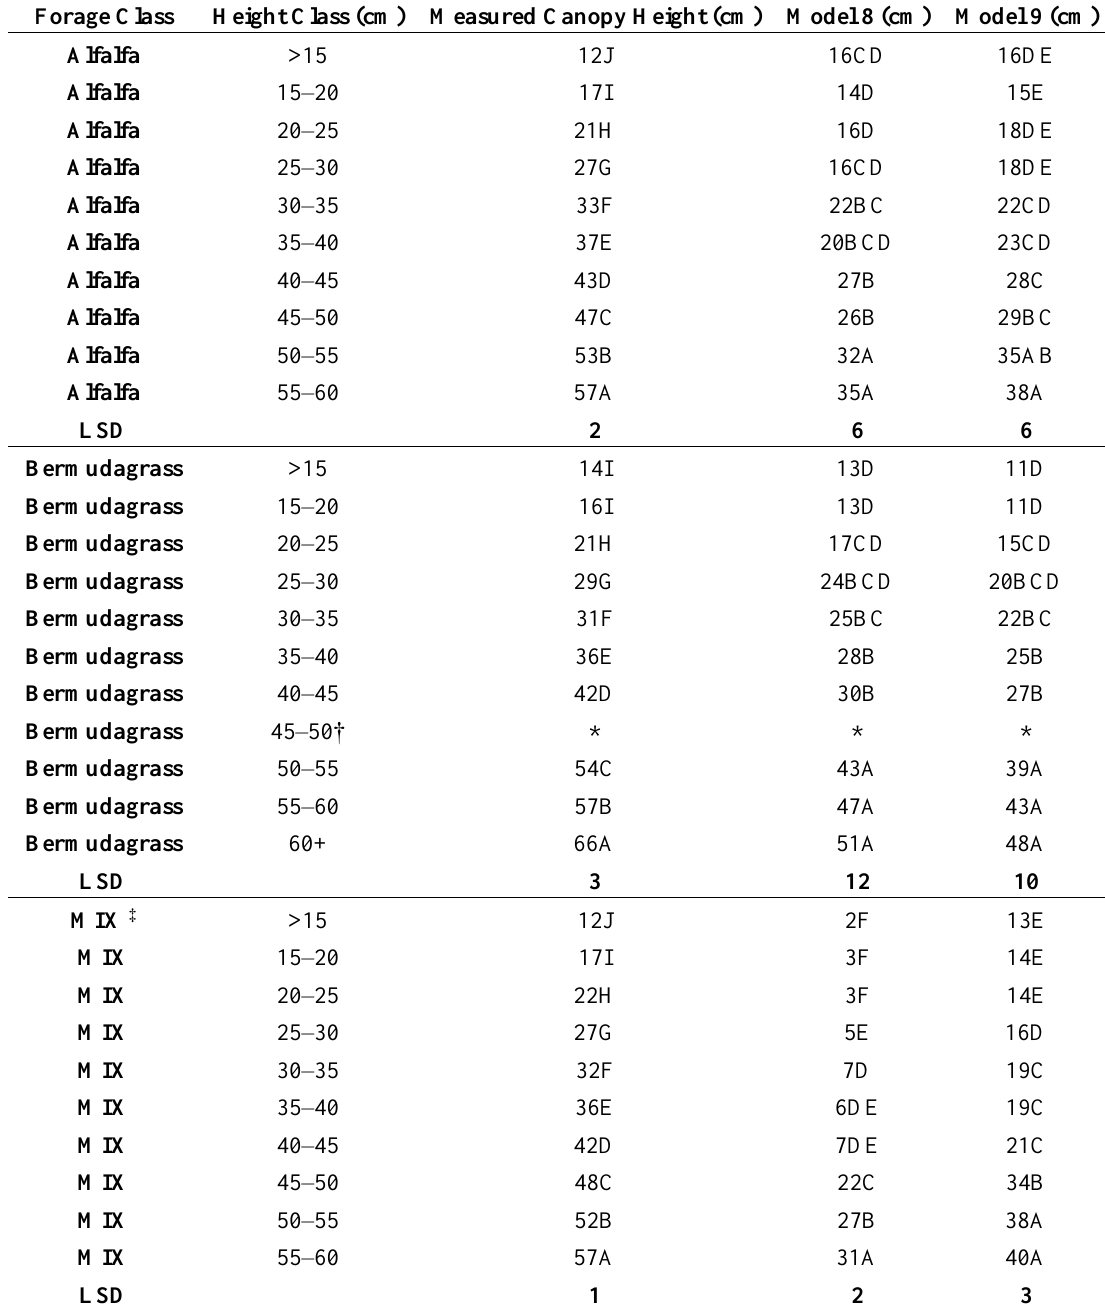
Table 7. Mean estimates for measured canopy height (cm) and sensor model estimates of canopy height (cm). † No height data occurred in this range for